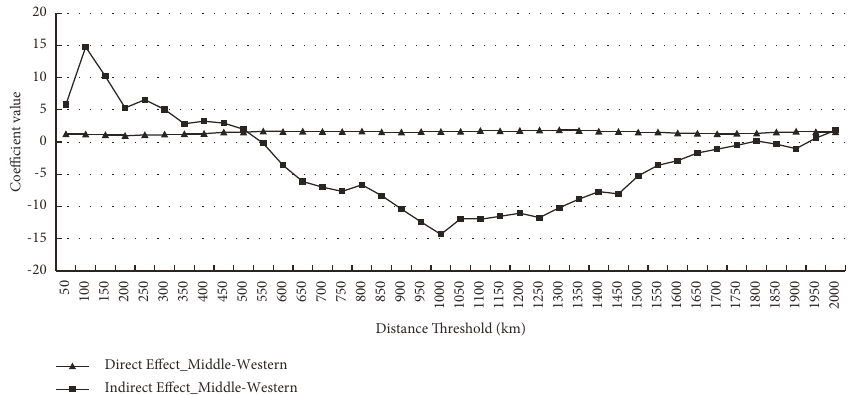
Figure 9: Spatial trends of the impact of the central and western regions’ digital economy on urban innovation.